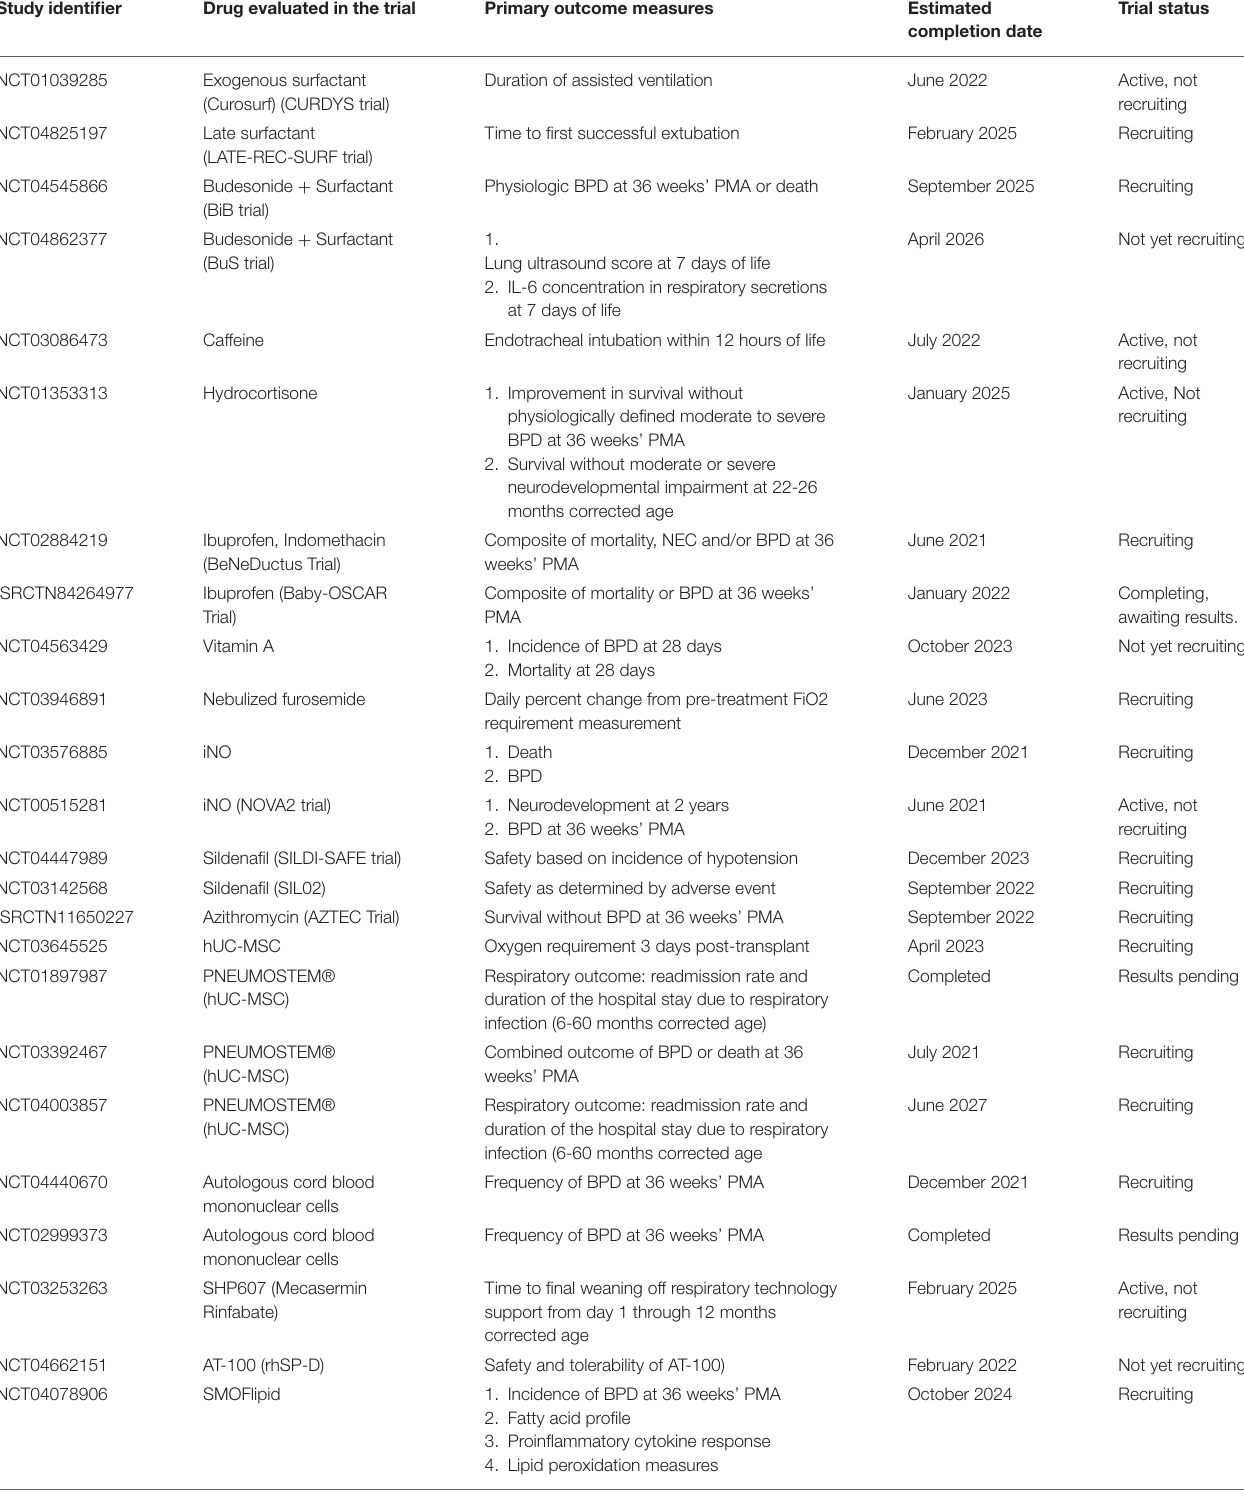
TABLE 2 | Ongoing randomized controlled clinical trials evaluating pharmacotherapy for BPD prevention/treatment listed on ClinicalTrials.gov/ISRCTN registry. Study